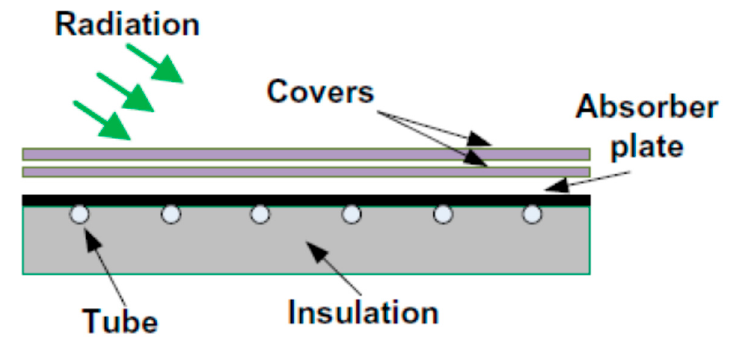
Figure 1. Schematic diagram of Flat plate collector. Adopt from